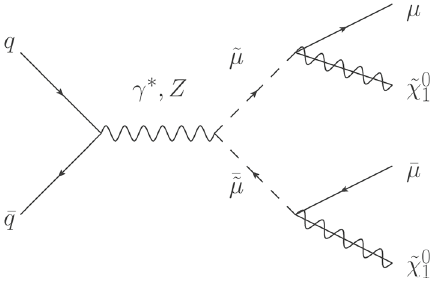
Fig. 2 Feynman diagram (at LO QCD) related to the indirect produc- tion of neutralinos by smuons